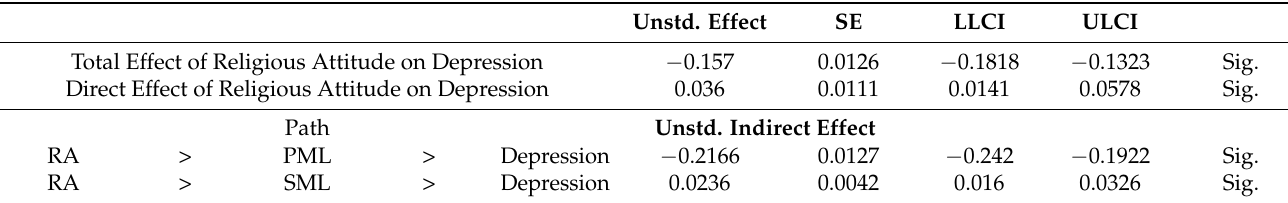
Table 5. Total, direct, and indirect regression analysis on